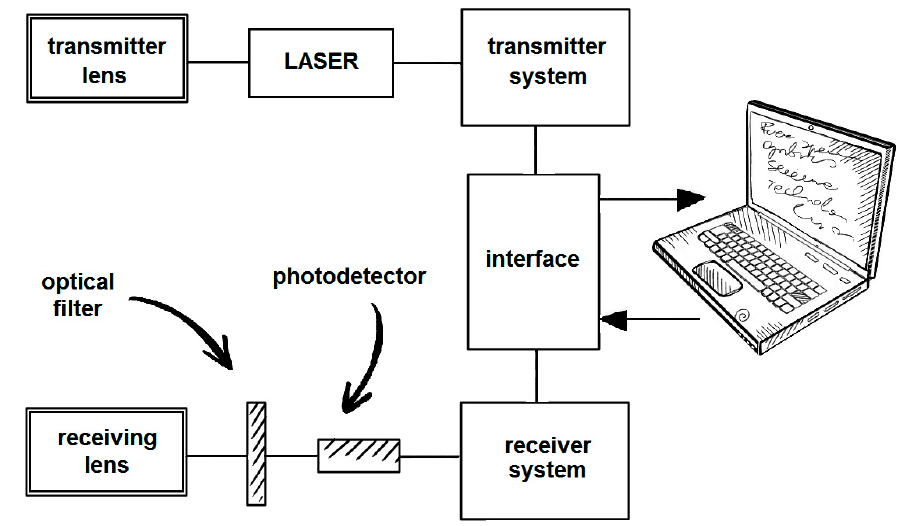
Figure 5. Block diagram of the FSO system.